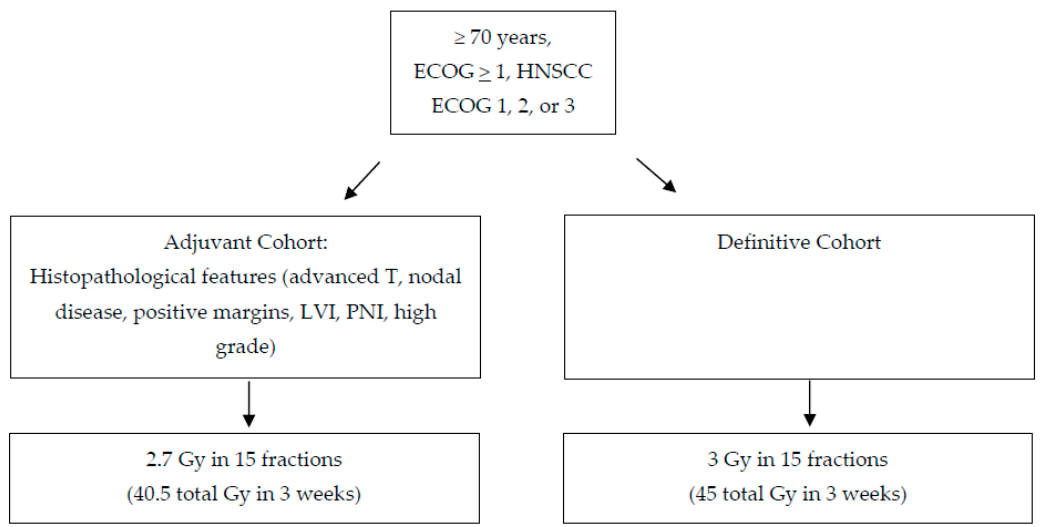
Figure 2. Schema of continuous hypofractionation for older adults with head and neck squamous cell carcinoma unfit for standard treatment. For older adults with head and neck cancer that are suitable for standard treatment, consider standard treatment or enrollment onto a de-escalation trial if p16 positive. Table 1. Ongoing Clinical Trials for Older adult Patients with Locally Advanced Head and Neck Cancer.